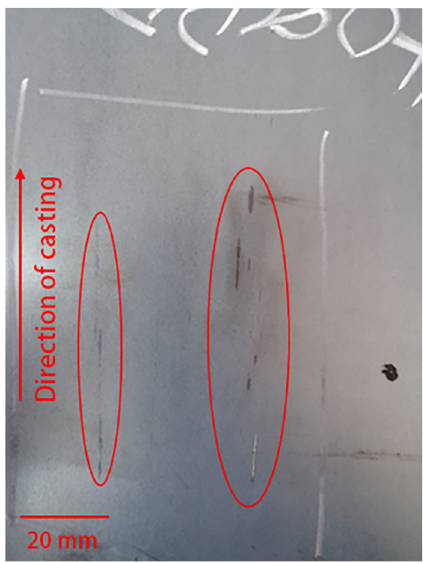
Figure 21: Sliver defects.